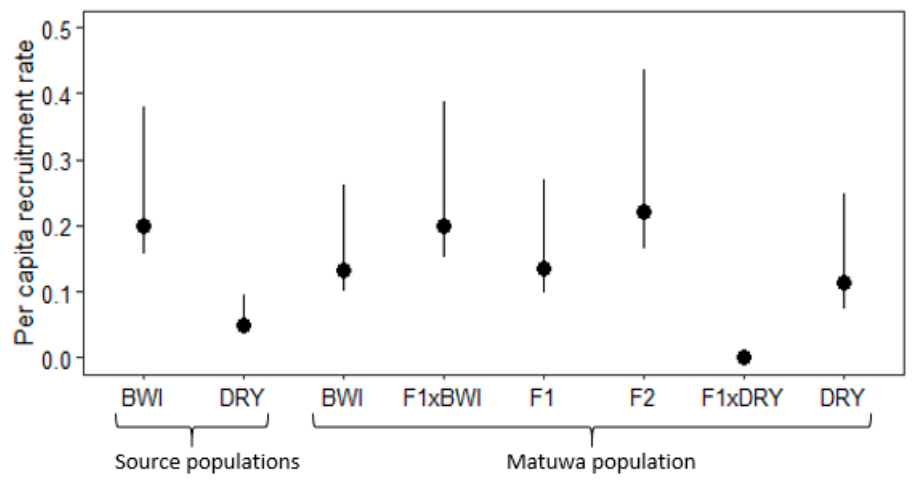
Figure 5. Average per capita recruitment rate with 95% confidence intervals for Bettongia lesueur individuals from founder populations; Barrow Island and Dryandra and each hybrid class of the translocated population; pure-bred Barrow Island (BWI), pure-bred Dryandra (DRY), backcross to Barrow Island (F 1 × BWI), F 1 hybrid (F 1 ), F 2 hybrid (F 2 ), backcross to Dryandra (F 1 × DRY) and pure-bred Dryandra (DRY).